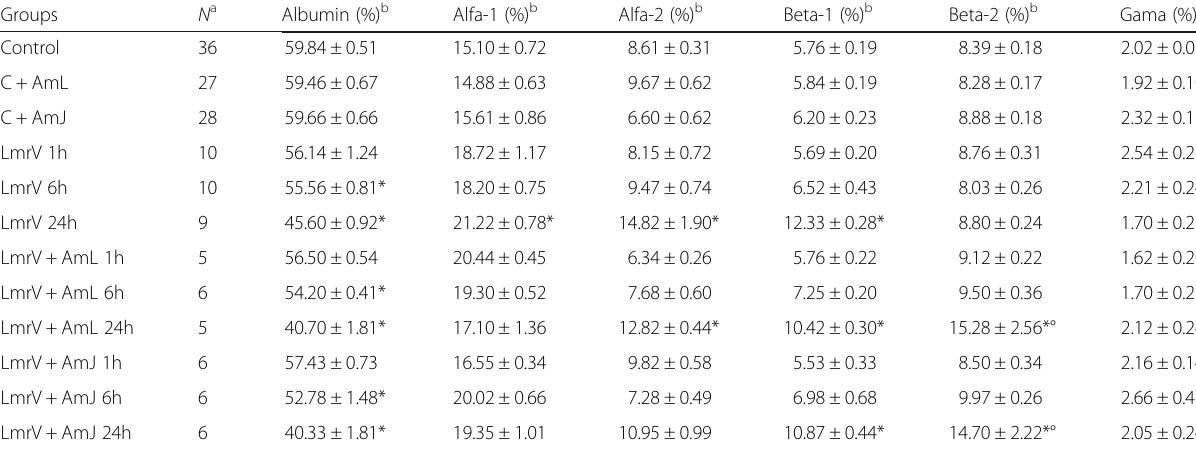
Table 1 Percentages of serum proteins of the animals at different times after envenomation Groups